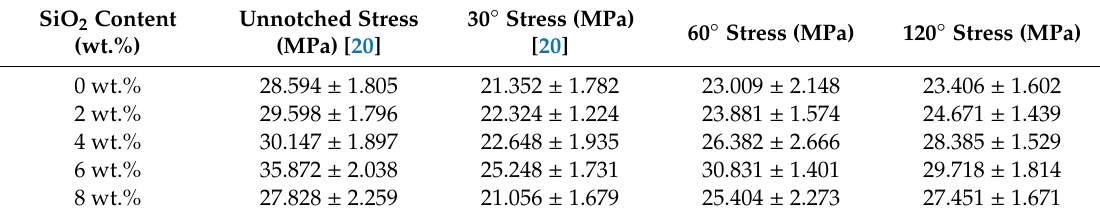
Table 1. The tensile strength of di ff erent notched forms.